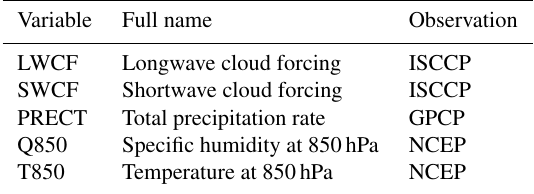
Table 2. The selected output variables of CAM5 included in the performance metrics and the sources of the corresponding observa-